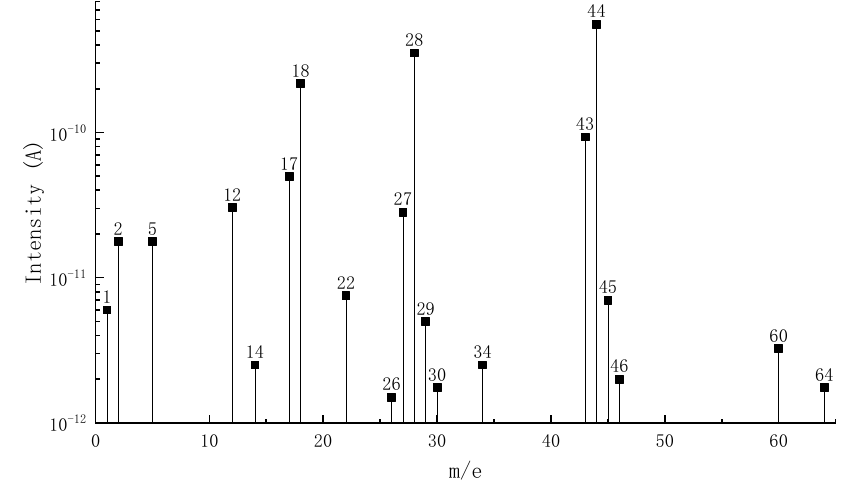
Figure 5. Mass spectrum of volatile matter from pyrolysis combustion of epoxy asphalt at charac- teristic temperature (510.9 °C).